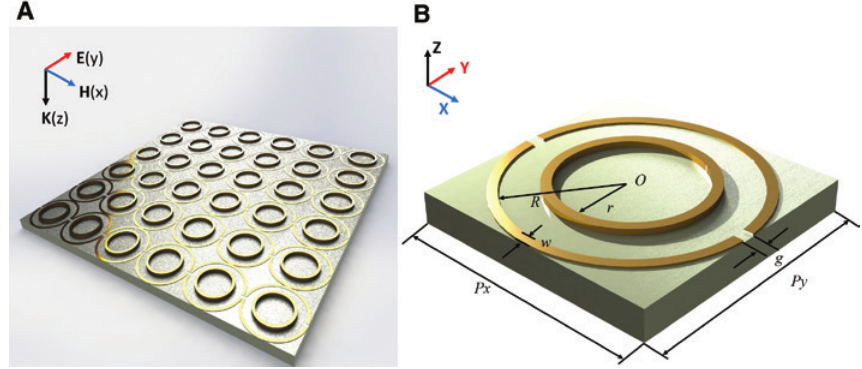
Figure 1: Structure of the enhanced EIT resonance. (A) Three dimensional schematic diagram of the undulated meta-surface. (B) Geometrical parameters of a unit cell: Px = 110 μ m, Py = 110 μ m, R = 110 μ m, r = 70 μ m, w = 4 μ m and g = 4 μ